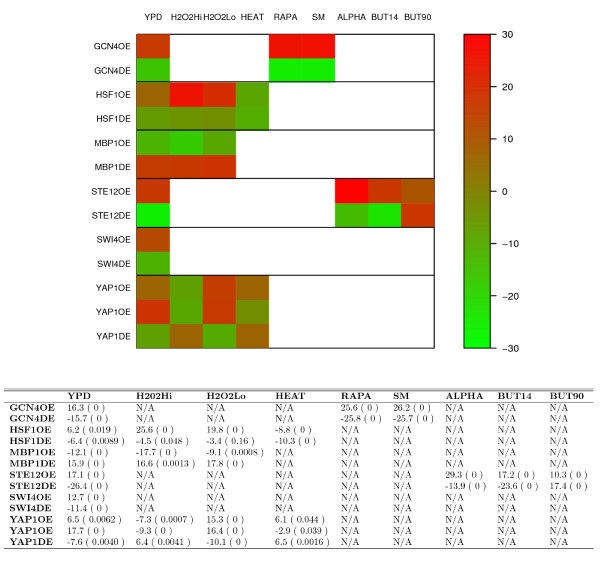
Comparison of inferred AC scores for 6 TFs in their corresponding over-expression and deletion TFPEs. The upper image shows the AC scores of Gcn4, Hsf1, Mbp1, Ste12, Swi4 and Yap1 under different combinations of the expression profiles and ChIP-chip data. The lower table shows the AC scores as well as the significance levels(in bracket). Each row represents the expression profile when the corresponding TF is over-expressed (OE) or deleted (DE). The columns correspond to all conditions under which the ChIP-chip data for the corresponding TF is measured. N/A means not available, which is due to the unavailability of the ChIP-chip data under the conditions for the TF. Note there are two rows for YAP1OE, each corresponding to an independent expression profile from Yap1 over-expression experiment.